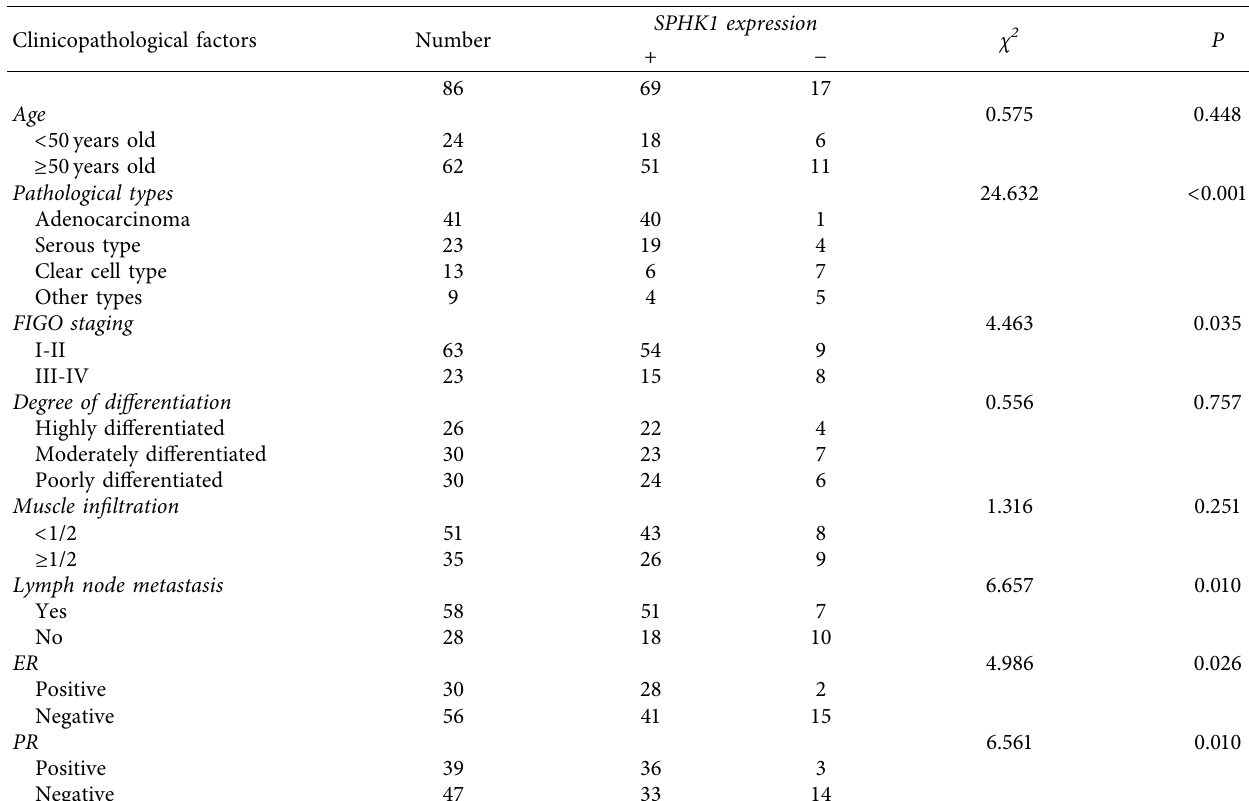
Table 3: The relationship between SPHK1 expression and clinicopathological factors in endometrial carcinoma. Clinicopathological